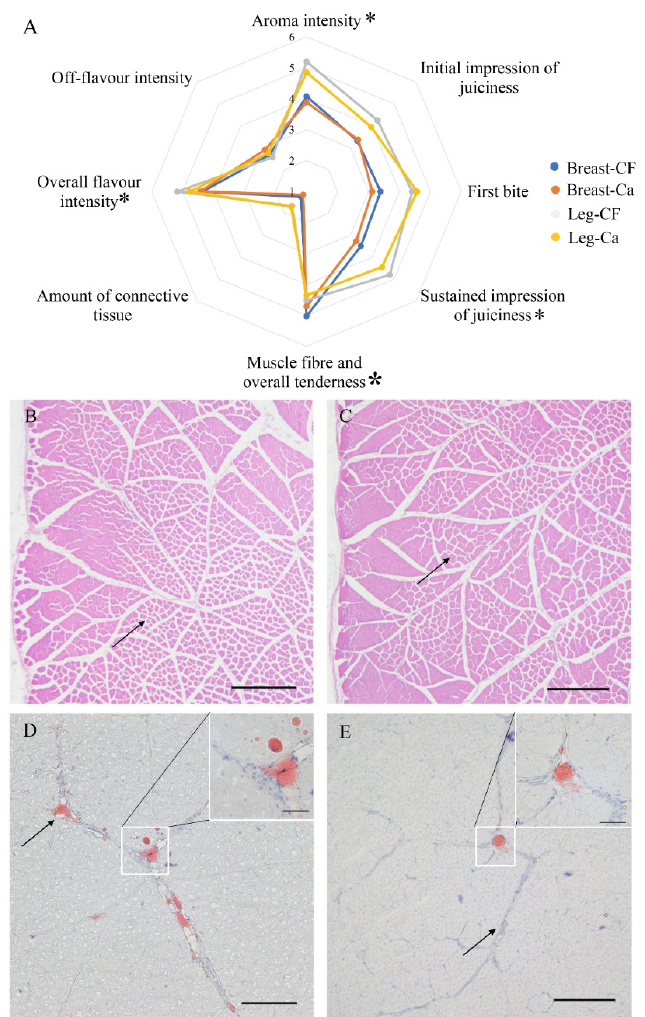
Figure 1. ( A ) Statistical analysis of sensory evaluation from different groups. Different colors refer to different parts of muscles and groups. “Breast” refers to breast muscle, “Leg” refers to leg muscle, “CF” refers to the cage-free group, and “Ca” refers to the cage-rearing group. The free-cage rearing significantly improved scores of aroma intensity, sustained impression of juiciness, overall flavor intensity of leg muscles (marked with “*”), and the score of muscle fiber and overall tenderness of breast muscles (marked with bold “*”). Morphological differences in leg muscles between the cage-free and caged groups. The paraffin section and hematoxylin-eosin (H&E) staining showed that the muscle fibers of the cage-free group ( B ) were looser than those of the caged group ( C ). Oil red O staining showed that there was more intramuscular fat deposited between the muscle bundles in the cage-free group ( D ) than in the caged group ( E ). The fat was stained red and indicated by the arrow. Normal scale bar, 100 µm; enlarged scale bar, 20 µm.